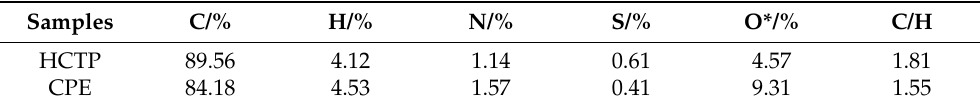
Table 1. Ultimate analysis of HCTP and CPE.